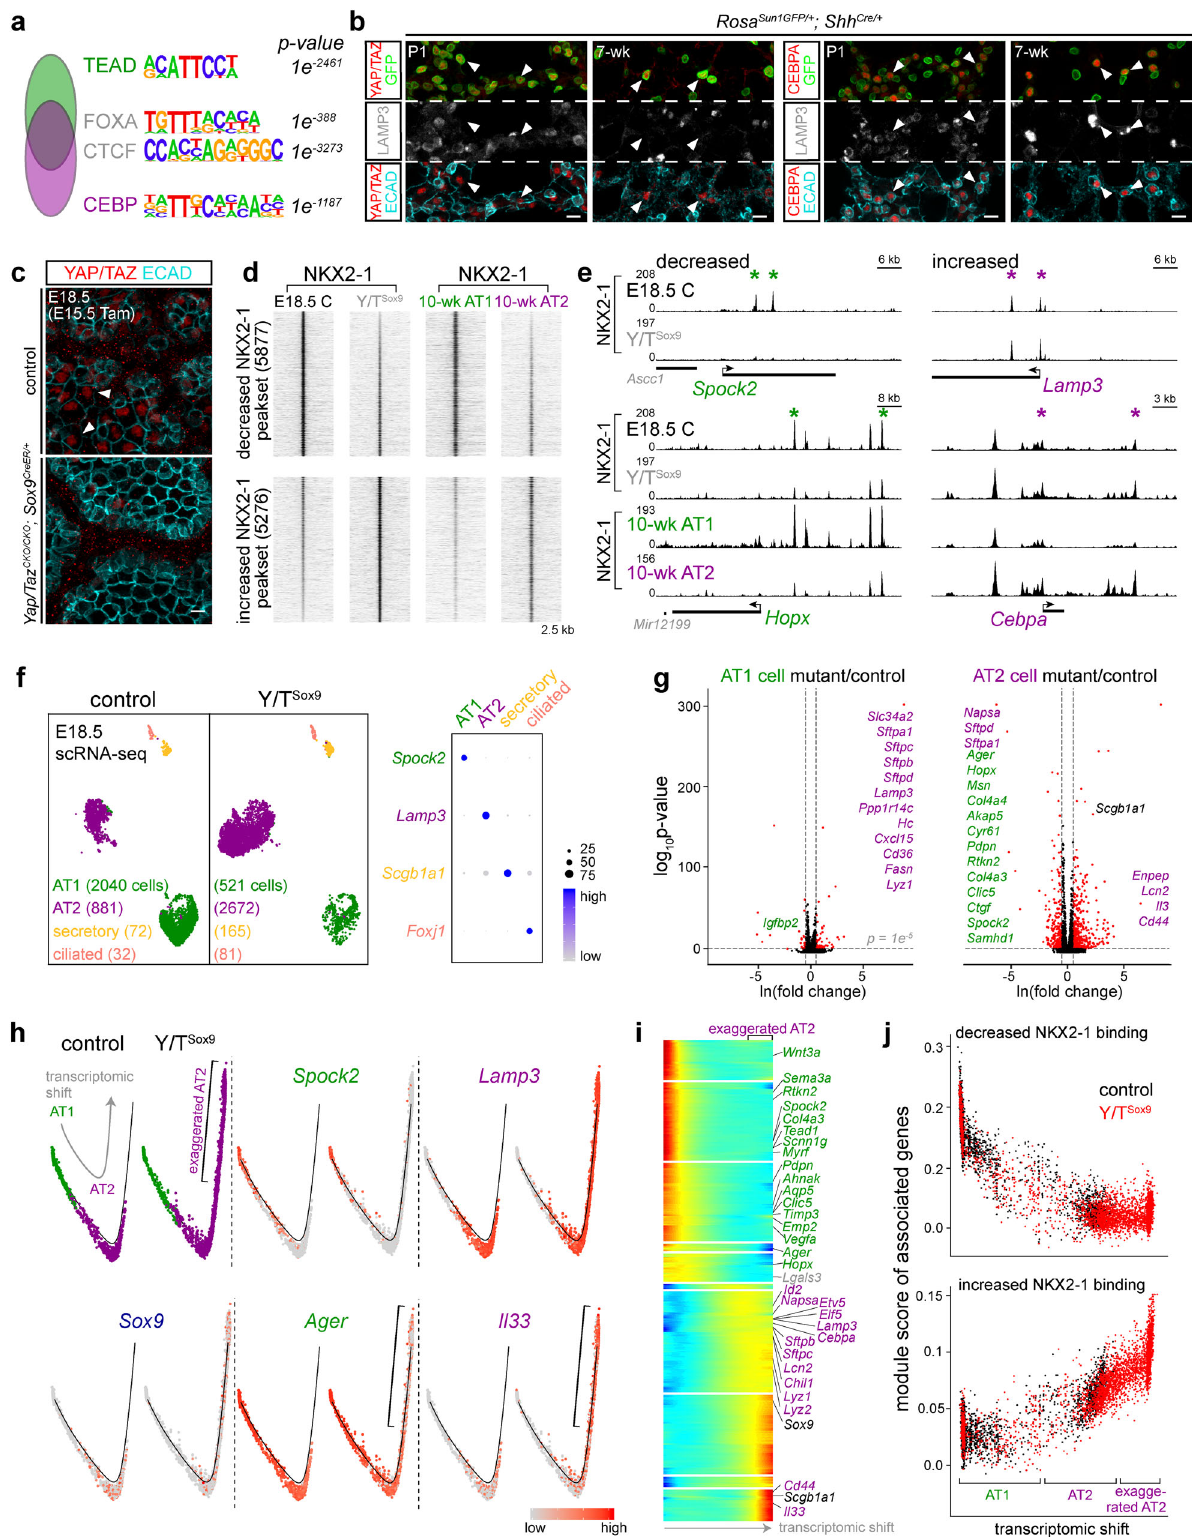
Supplementary Data 6), suggesting considerable plasticity of AT1 cells such that NKX2-1 relocated to AT2-speci fi c sites in the absence of